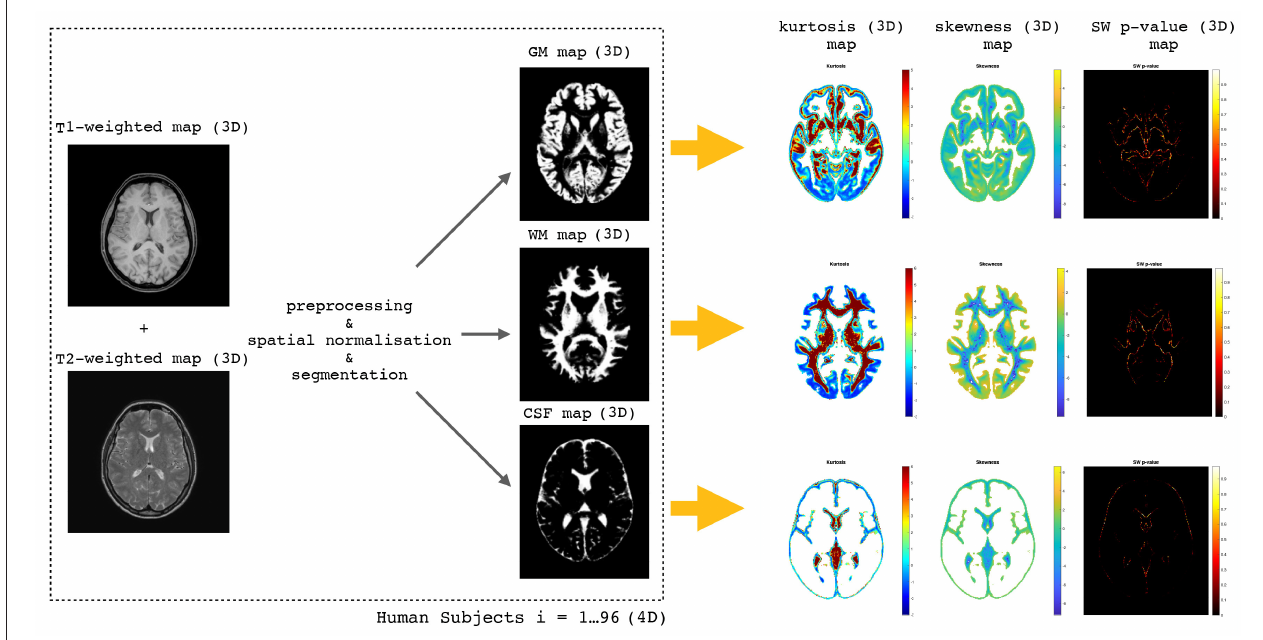
FIGURE 1 | The flow chart of the whole methodology starting from T1-weighted and T2-weighted maps (3D) through the preprocessing, spatial normalization, and segmentation steps to obtain WM, GM, and CSF 3D maps. Having 96 human subjects we obtain 4D maps which are used to perform voxel-wise distributions of skewness, kurtosis, and SW test p